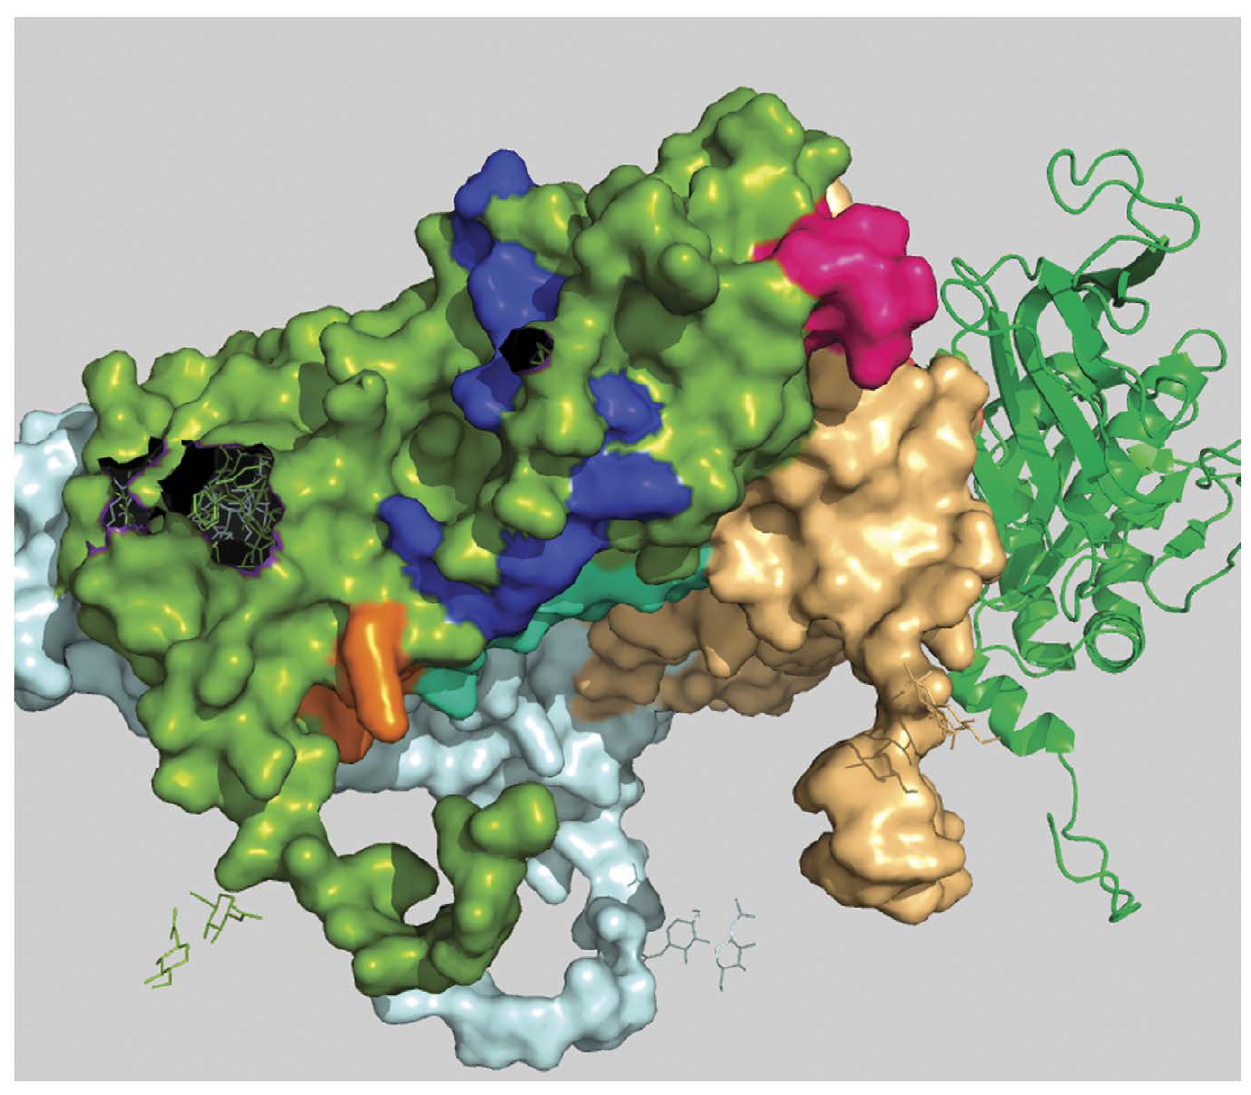
Figure 6. Position of Peptide-b is shown from inner surface of the virion in 3D-space filling model of rotaviral trimeric VP7. Lower part of Peptide-b (aa 242 to aa 255) is shown in blue color. It’s the same blue peptide as in Figure 5.